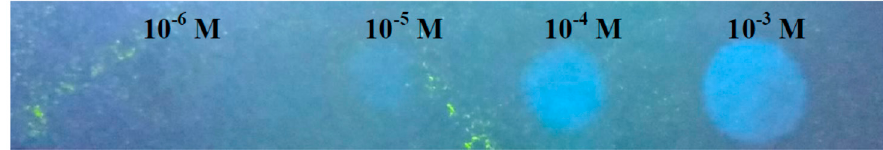
Figure 5. Color changes by UV light for probe L (40 μ M) in different sources of water (DMSO : H 2 O = 1 : 9 v/v) containing 5 equiv. of Al 3+ . Figure 6. The color changes of probe L observed by UV light upon the addition of Al 3+ at different concentrations in the filter paper.